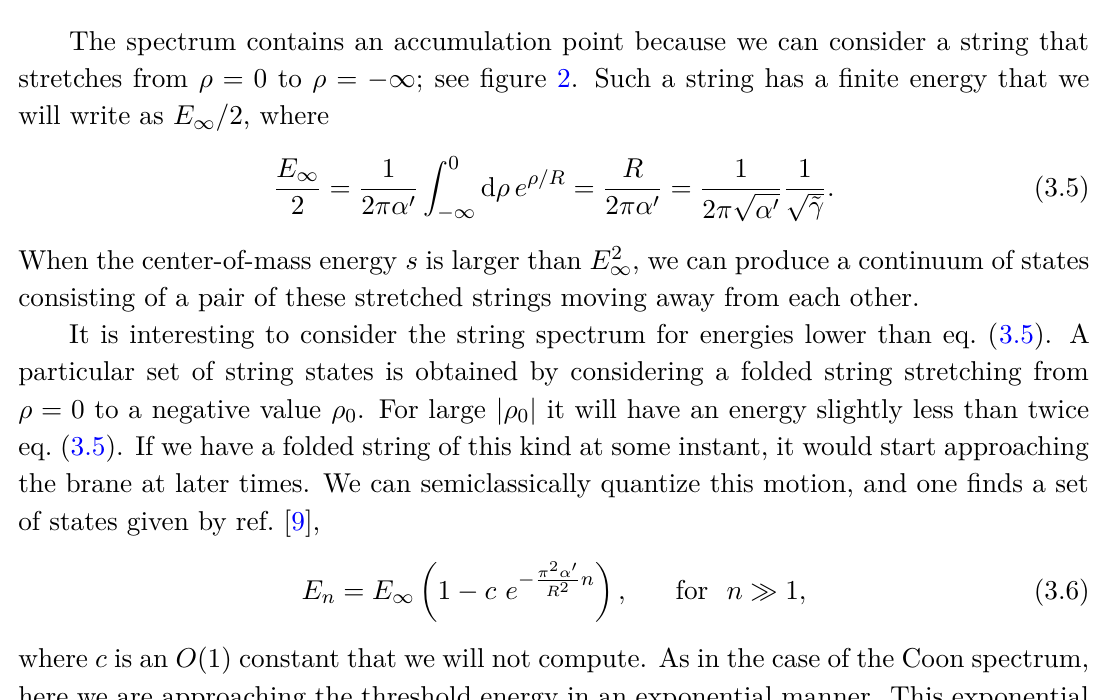
Figure 2 . Various string configurations discussed in the text. In purple, we depict a string stretching between the brane (blue) and the horizon (yellow). A pair of such strings has the energy of the continuum threshold. In red, we show a state of a lower energy consisting of a folded string that stretches up to a finite distance from the brane, with the endpoint momentarily at rest. This endpoint will start moving towards the brane. Finally, the spinning string is depicted in